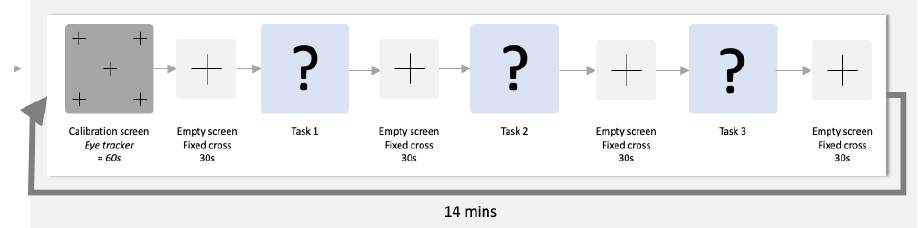
Figure 1. Schematic representation of an experiment run.